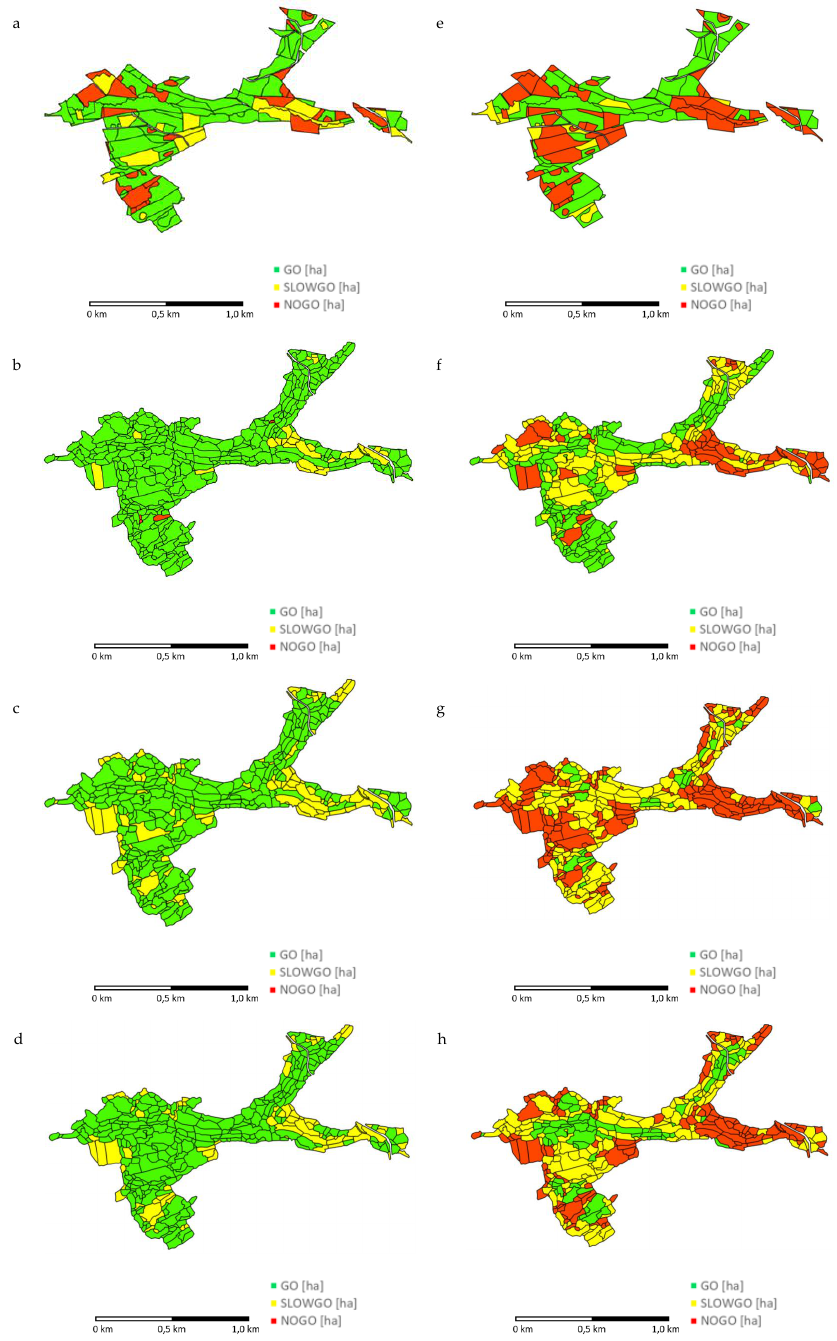
Figure 5. The map of passability through the selected Forest Bačetín for a light wheeled vehicle (left) and armored tracked vehicle (right), data Forest Economic Plan FEP-based (upper), DSM 1G tree positions (middle), orthophoto DMS-based data (lower); green—GO, orange—SLOW GO, red—NO GO areas: ( a ) for a light wheeled vehicle LRD 110, data FEP, ( b ) for a light wheeled vehicle LRD 110, data DSM 1G—trees, ( c ) for a light wheeled vehicle LRD 110, data DSM 1G—sorted (5 classes), ( d ) for a light wheeled vehicle LRD 110, data DSM from orthophoto, ( e ) for an armored tracked vehicle BVP-2, data FEP, ( f ) for an armored tracked vehicle BVP-2, data DSM 1G—trees, ( g ) for an armored tracked vehicle BVP-2, data DSM 1G—sorted (5 classes), ( h ) for an armored tracked vehicle BVP-2, data DSM from orthophoto.